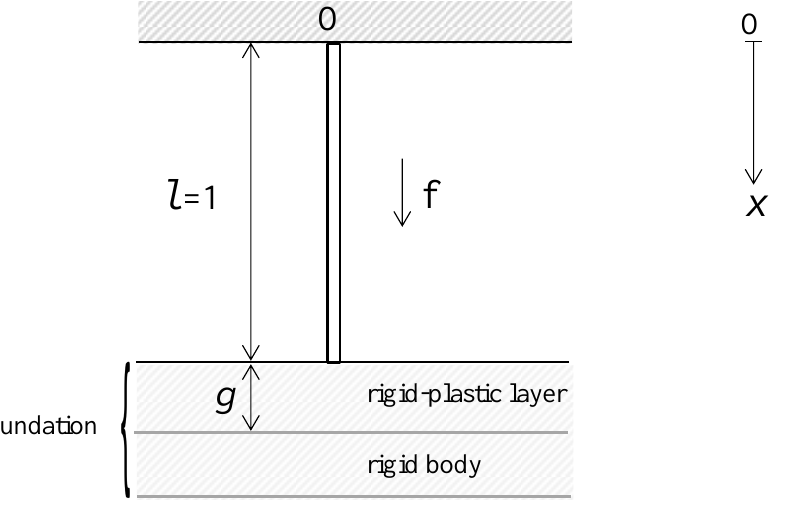
Figure 3. Physical